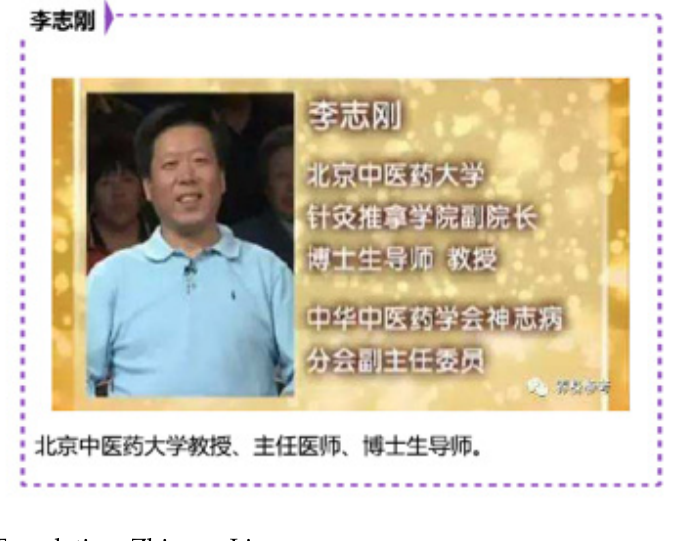
Figure 2. Expert introduction part in the article entitled “Stick to this action for a minute a day, and you won’t have high blood pressure, diabetes, or